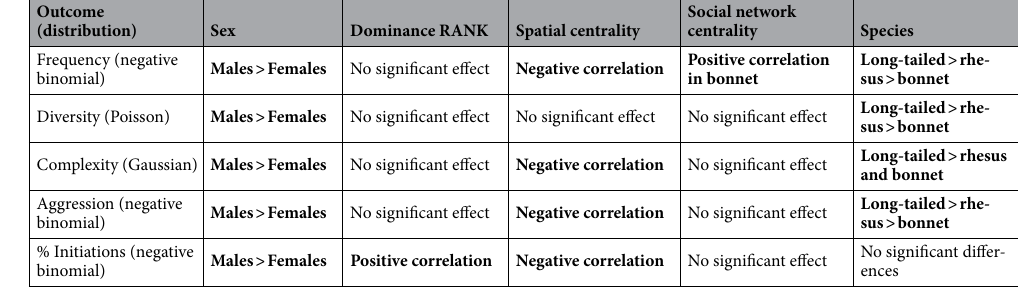
Table 6. Summary of results from the best-fit GLMMs for each aspect of human–macaque interactions. Entries in bold font indicate significant effects (p <